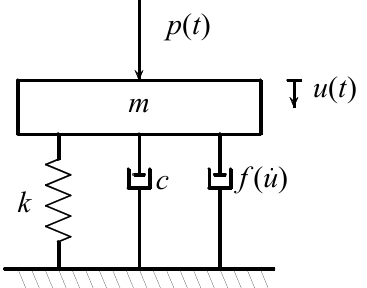
Figure 4. Sketch map of the SDOF system with the ECD subjected to external loading.